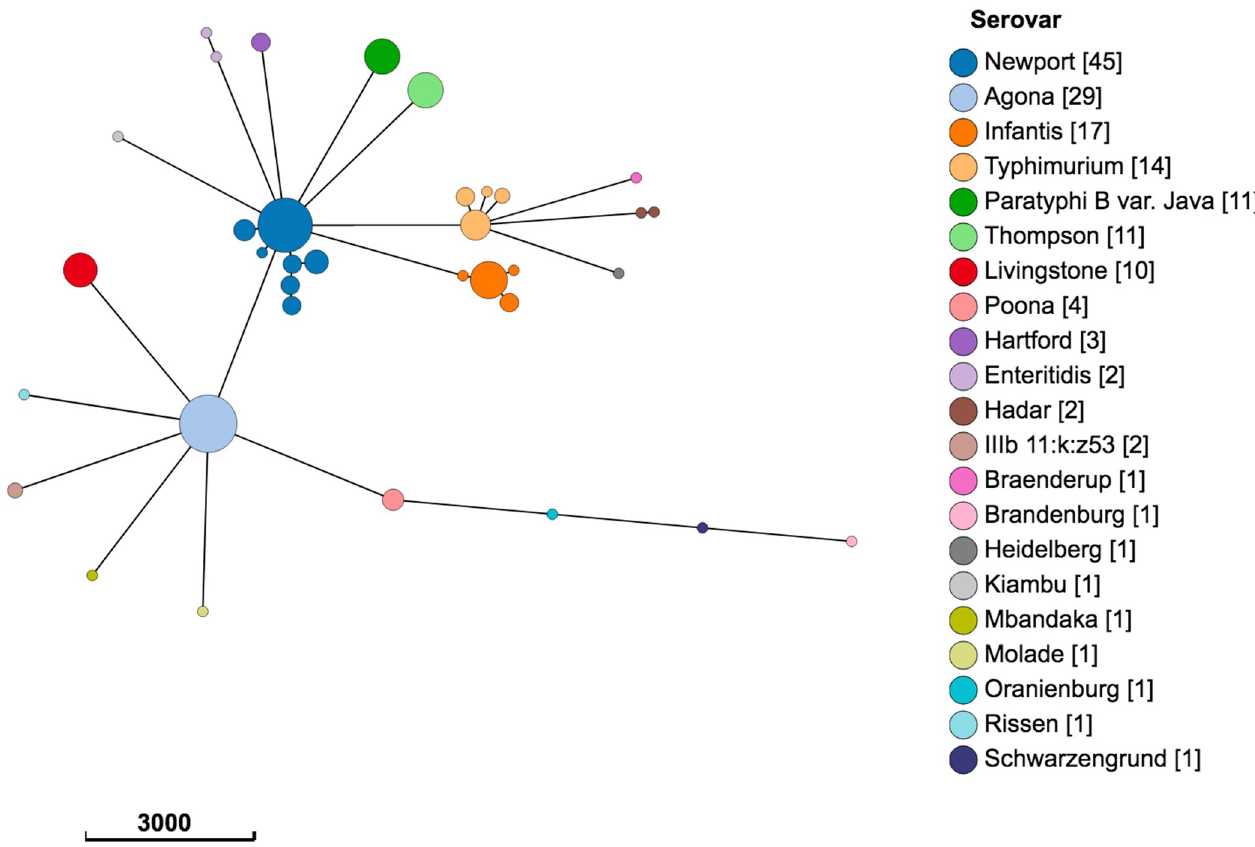
Fig 1. Population structure of 159 Salmonella enterica isolates from raccoons, swine manure pits, and soil samples on swine farms in southern Ontario, Canada based on 3002-loci cgMLST scheme from Enterobase. Minimum spanning tree created using k = 30 clustering threshold in GrapeTree . Serovars determined using SISTR. Three isolates (2 raccoon, 1 soil) were not typeable by MLST. Frequency counts are in square brackets. Bubble size is proportional to the number of isolates in each cluster, and each cluster contains isolates differing at a maximum of 30 cgMLST